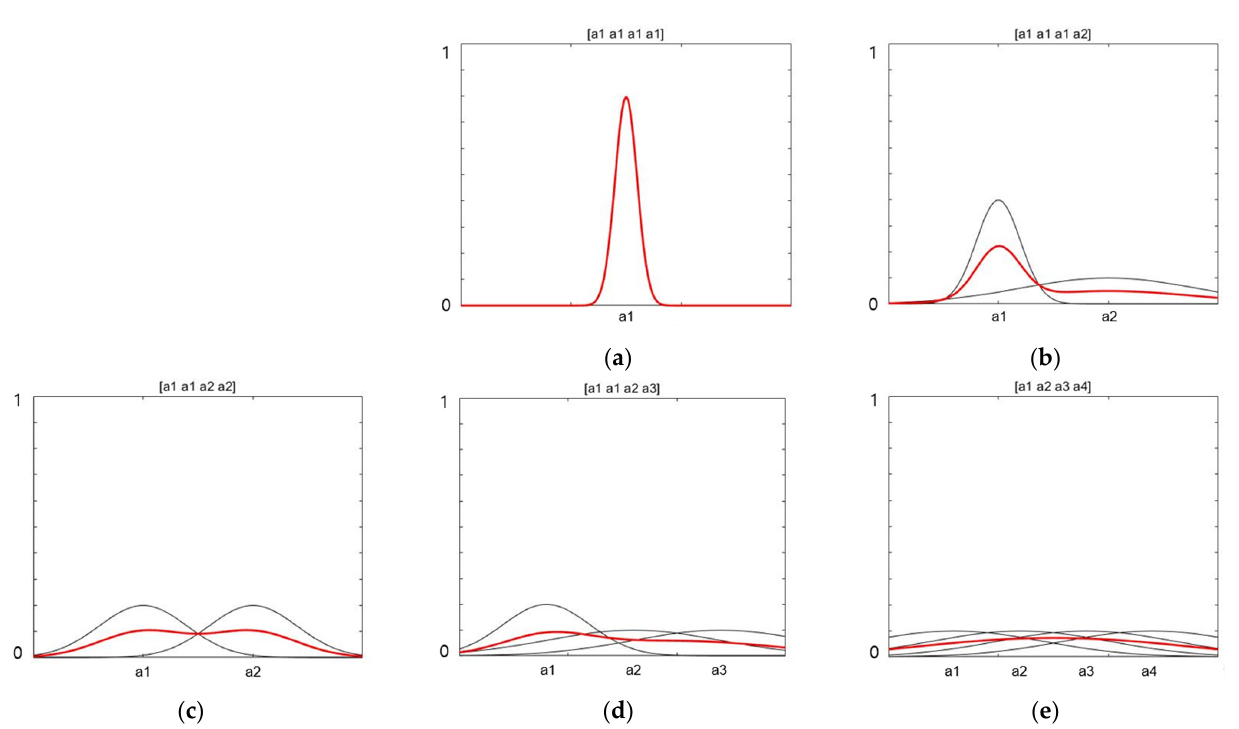
Figure 14. Simplified combinations of probability functions: ( a ) [ a (cid:2869) a (cid:2869) a (cid:2869) a (cid:2869) ], ( b ) [ a (cid:2869) a (cid:2869) a (cid:2869) a (cid:2870) ], ( c ) Figure [ a (cid:2869) a (cid:2869) a (cid:2870) a (cid:2870) ], ( d ) [ a (cid:2869) a (cid:2869) a (cid:2870) a (cid:2871) ], and ( e ) [ a (cid:2869) a (cid:2870) a (cid:2871) a (cid:2872) ]. Table 4. Specified standard deviation for each number of repeated damage centers.